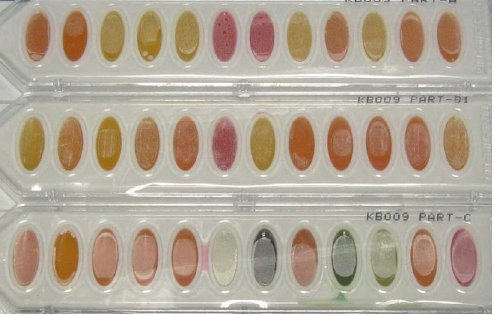
Fig. 4. Hi-Carbohydrate kit sugar utilization result for the isolated strain HYJE003 .